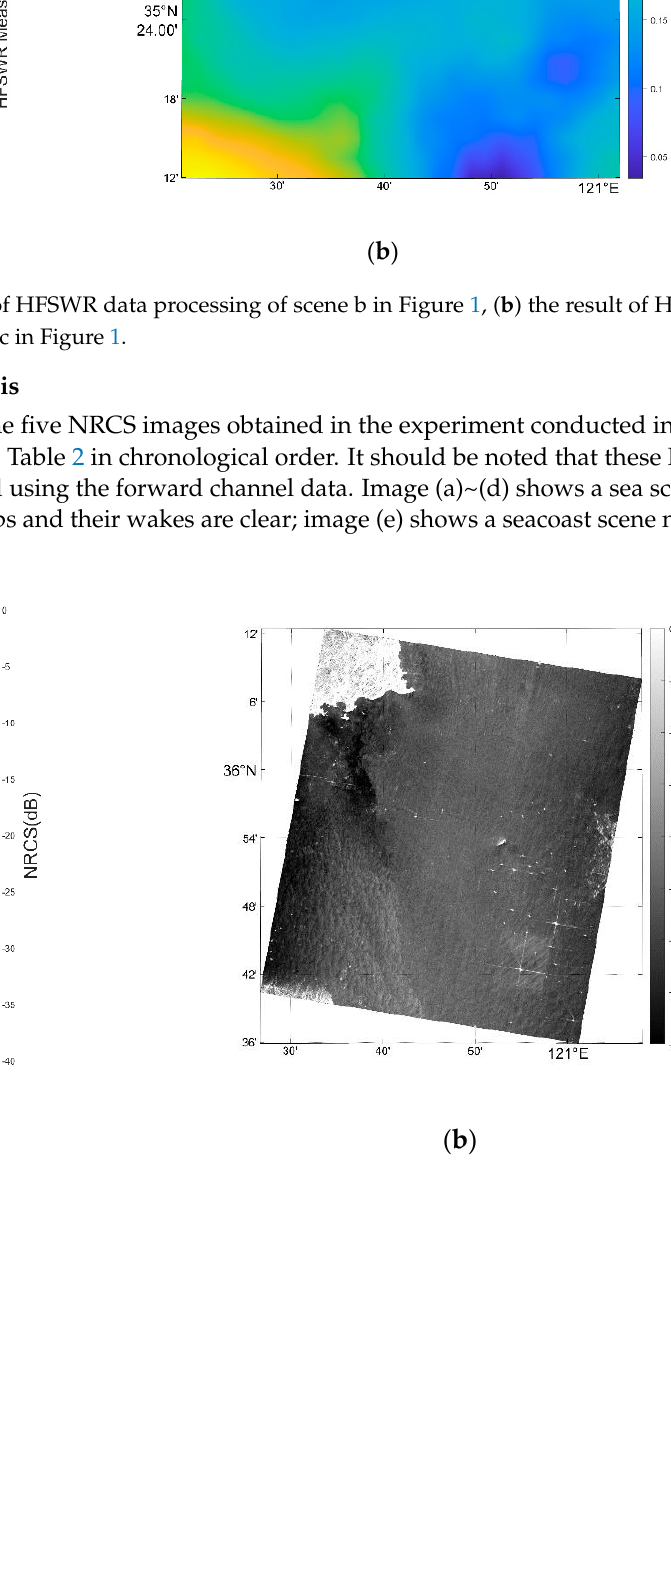
( d ) ( e ) Figure 7. NRCS images of the five GF−3 ATI images acquired in Qing Dao. (a)~(e) are the NRCS of region a to region b in figure 1.